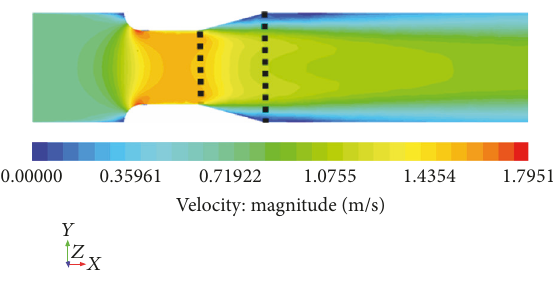
Figure 14: Nominal diffuser geometry and its velocity distribution.